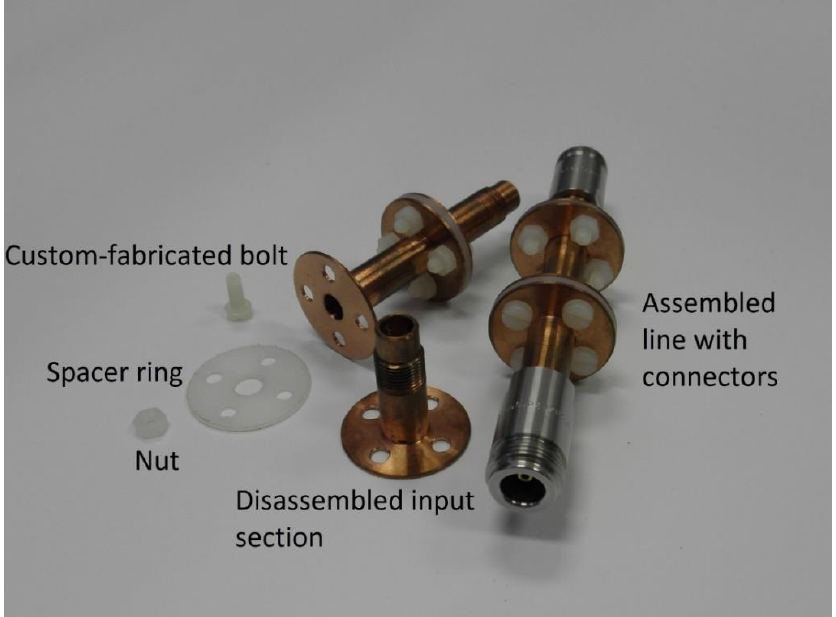
Figure 14. Manufactured adiabatic line prototype .